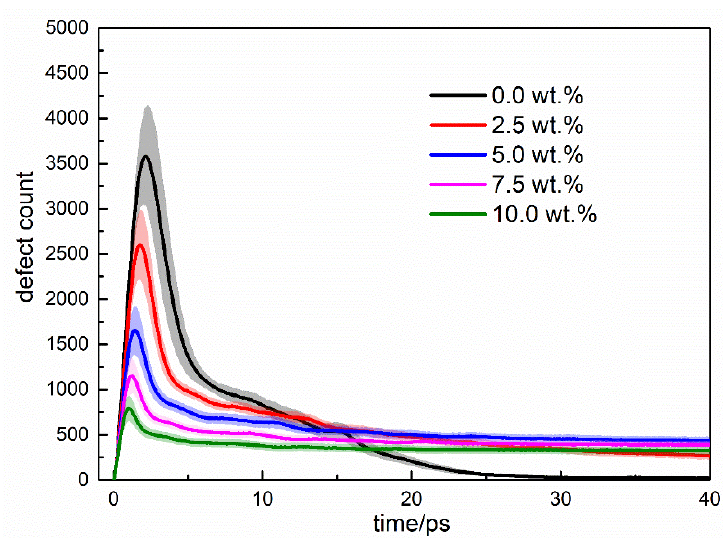
Figure 4. Time evolutions of the defect count in U-Mo systems with different Mo contents.